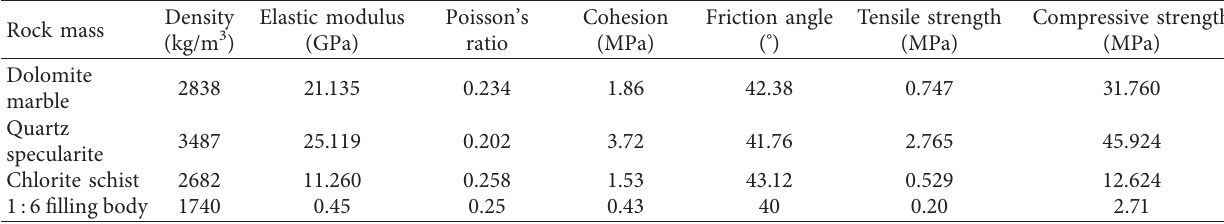
Table 2: Mechanical parameters of Lilou Iron Mine-related rock